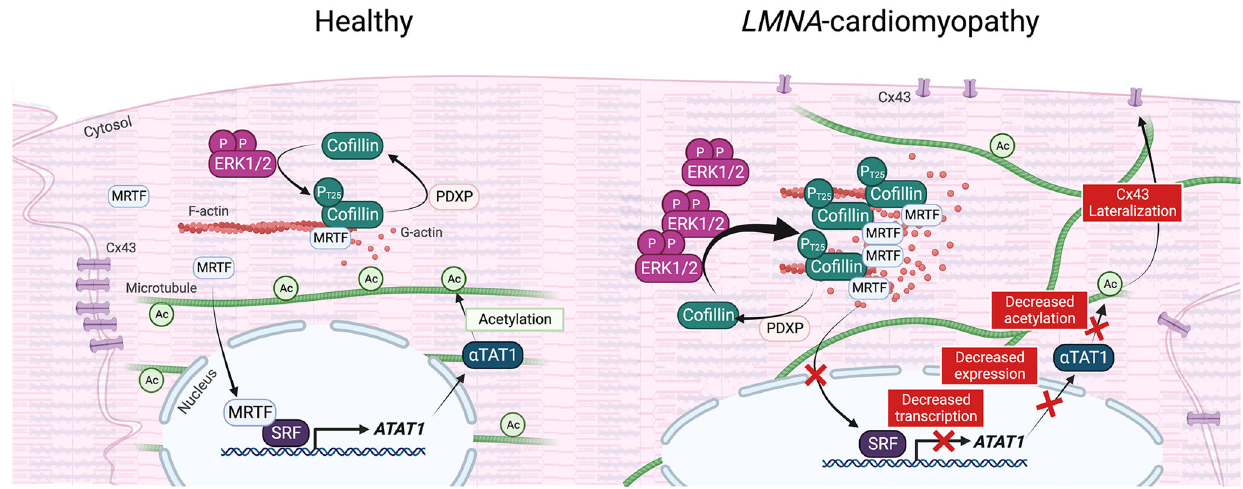
Fig. 7 | Schematic representation of the actin-microtubule interplay mediated by phospho(T25)-co fi lin-1 via MRTF-A/SRF signaling and α -tubulin acetylation in LMNA -cardiomyopathy. Created with